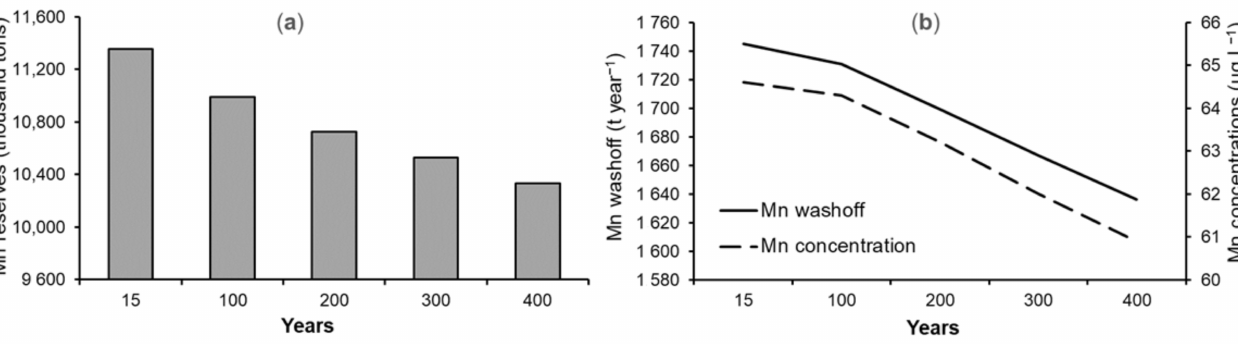
Figure 12. Changes in Mn reserves in soils ( a ), wash-off intensity, and Mn concentration in river waters ( b ) over a 400-year self-purification period.